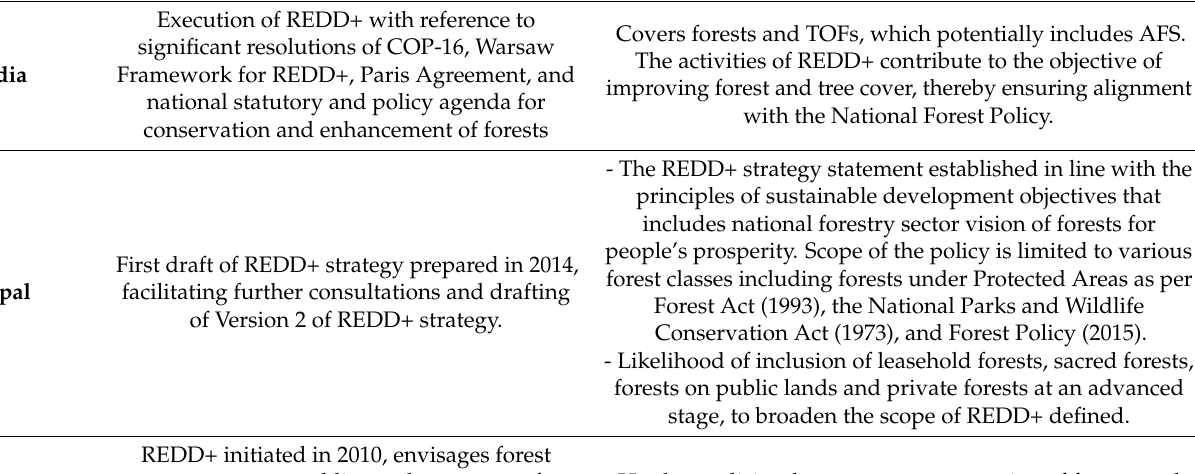
Table 6. Reduced Emissions from Deforestation and Degradation+ policies and strategies in S. Asian countries. Country Status Scope of